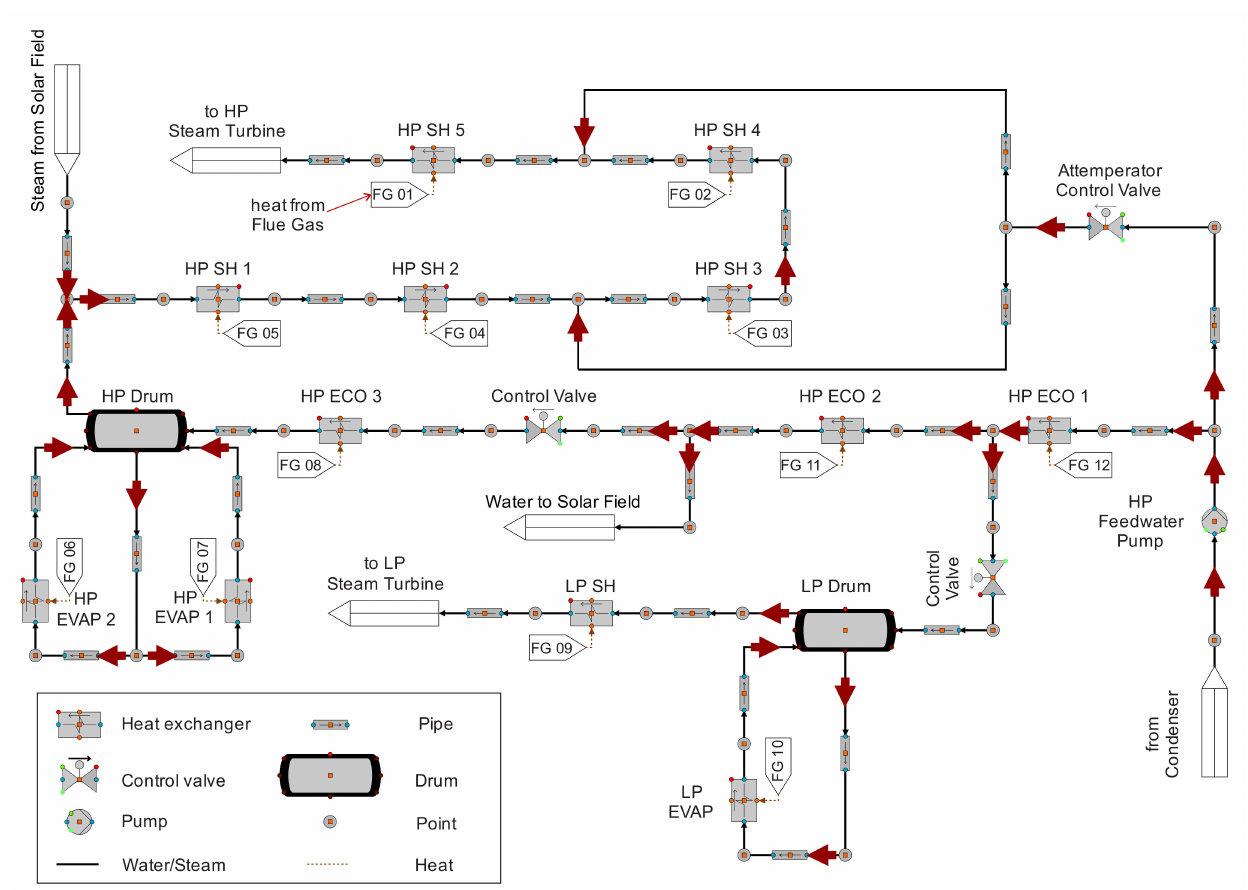
Figure 3. Schematic of the HRSG net in